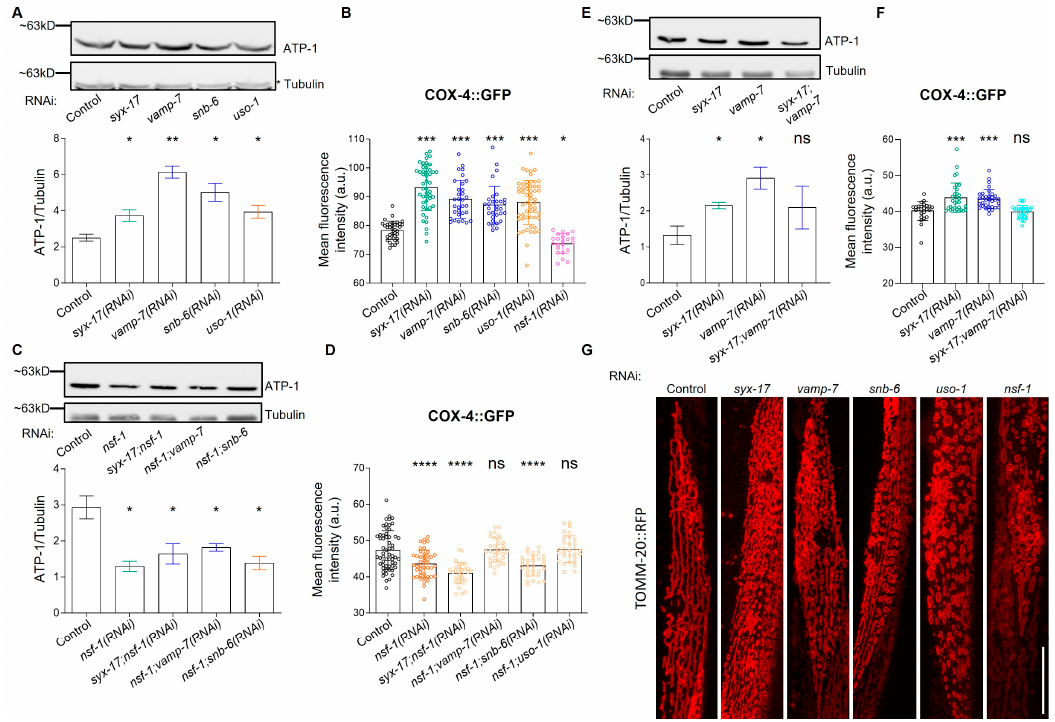
Figure 2. mitoSNAREs regulate mitochondrial abundance in an NSF-1-dependent manner. ( A ) Im- munoblot analysis of total ATP-1 protein levels of adult day 1 animals fed with the indicated dsRNA expressing bacteria (upper panel) and the respective quantification of the normalized protein levels (lower panel). n = 2 biologically independent experiments (p syx-17(RNAi) = 0.0423, p vamp-7(RNAi) = 0.0056, p snb-6(RNAi) = 0.0215, p uso-1(RNAi) = 0.0373, ** p < 0.01, unpaired two-tailed t -test). ( B ) Quantification of the total COX-4::GFP protein levels in adult day 1 animals fed with the depicted dsRNA expressing bacteria ( n = 202, p nsf-1(RNAi) = 0.03, *** p < 0.001, one-way ANOVA). The ex- periment was performed in 3 biological independent replicates with similar results. ( C ) Immunoblot analysis of total ATP-1 protein levels of adult day 1 animals fed with the indicated dsRNA express- ing bacteria (upper panel) and the respective quantification of the normalized protein levels (lower panel). n = 2 biologically independent experiments (* p < 0.05 unpaired two-tailed t -test, ns denotes non-significant differences). ( D ) Quantification of the total COX-4::GFP protein levels in adult day